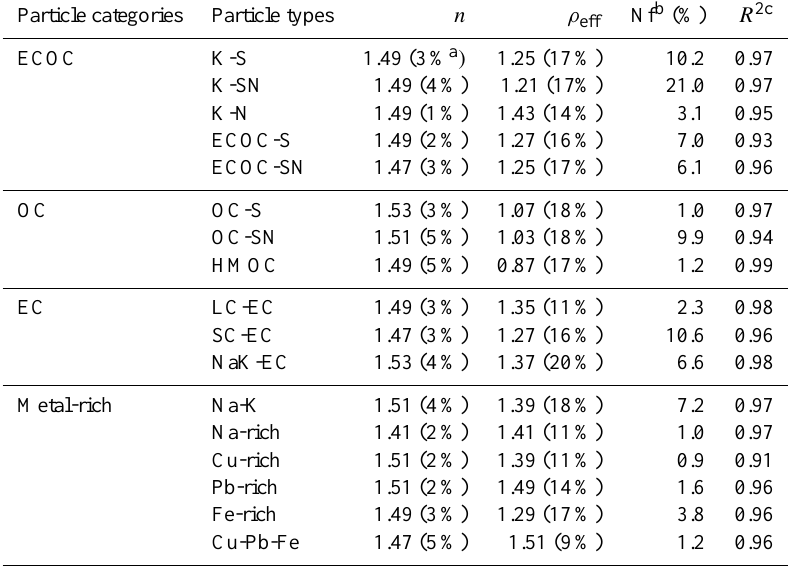
Table 1. Retrieved n and ρ eff , and the fractional contribution of 17 particle types detected during the sampling period. Particle categories